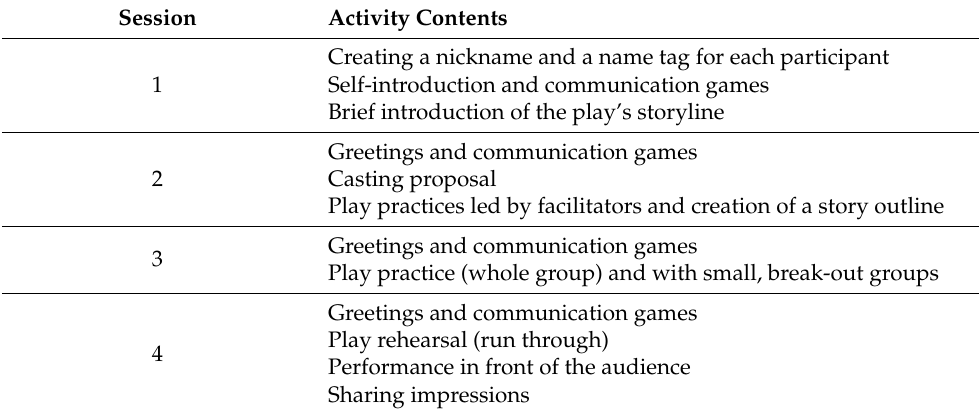
Table 1. Theater Together Project (1 h per